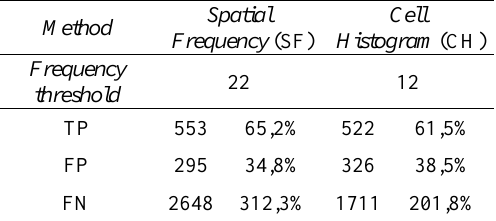
Table 1. Higher TP ocurrences for SF and CH filters